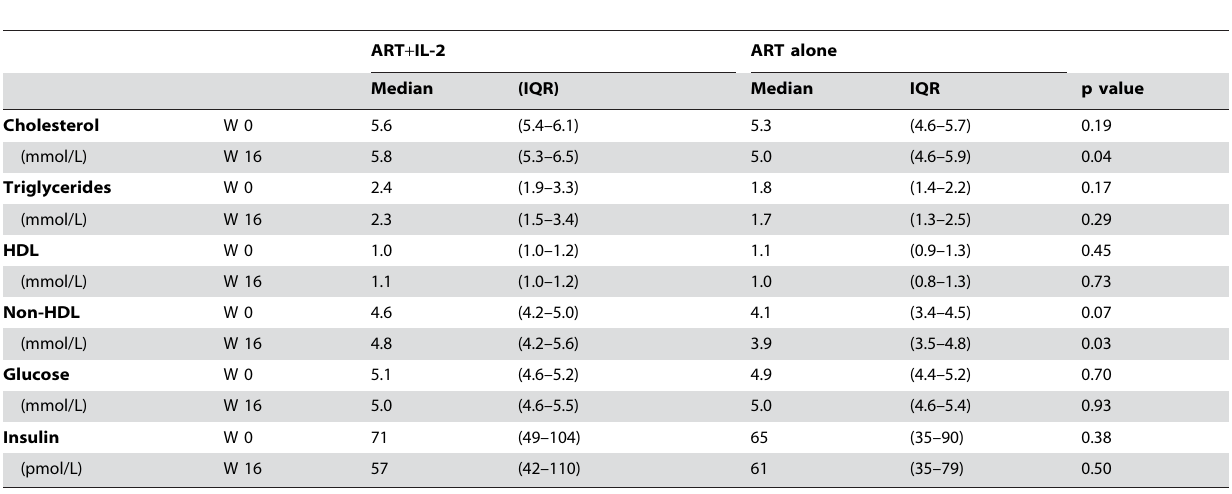
Table 1. Summary of changes in lipid and glucose parameters during Step 1 of the trial, when participants were receiving ART with or without